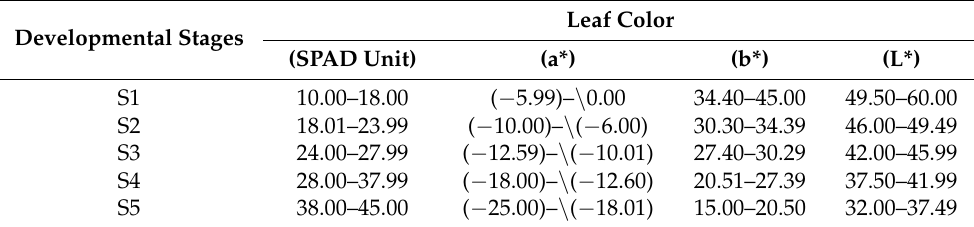
Table 2. Changes in leaf color ranges (leaf greenness, a*, b*, and L*) in Canephora coffee leaves at different stages.